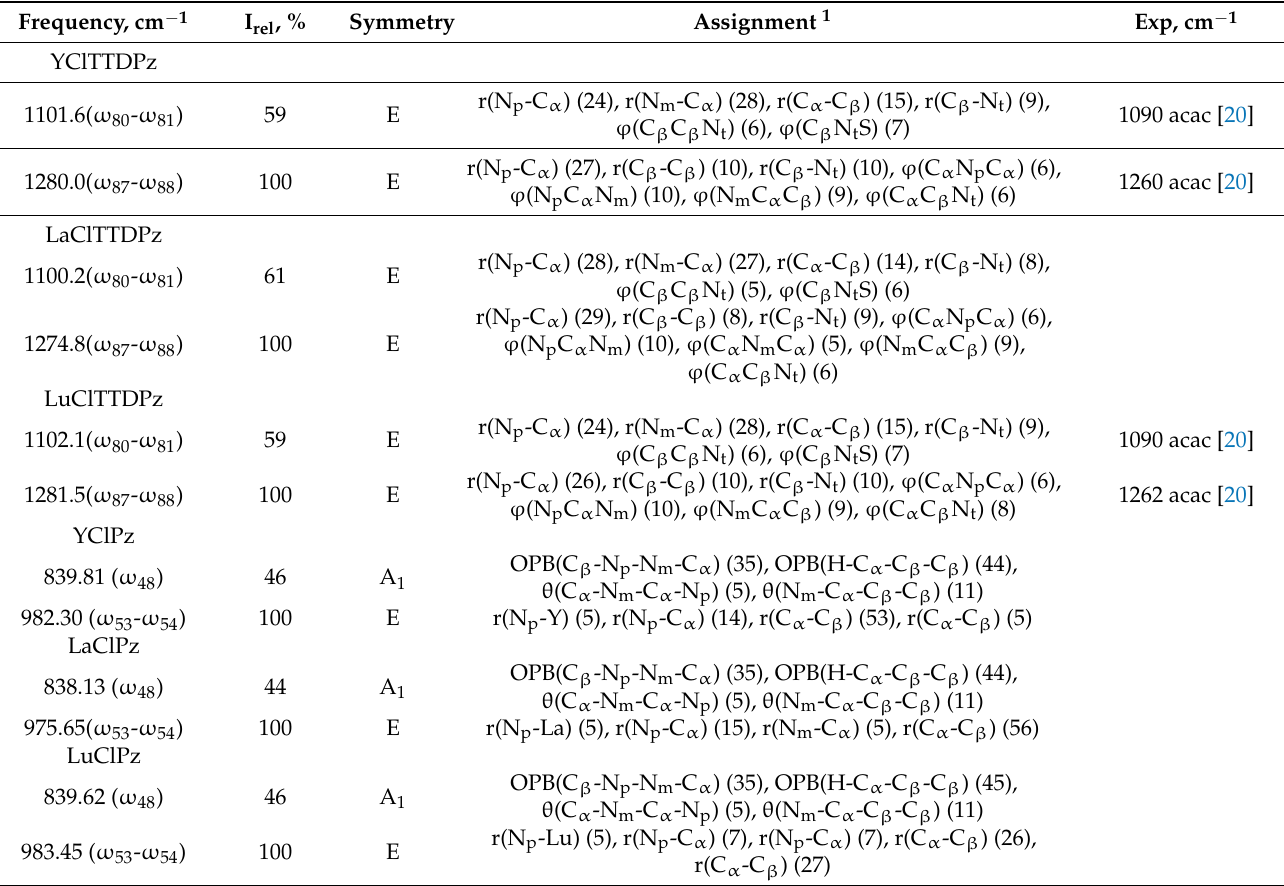
Table 4. Assignment of the IR vibrations of the MClPz and MClTTDPz